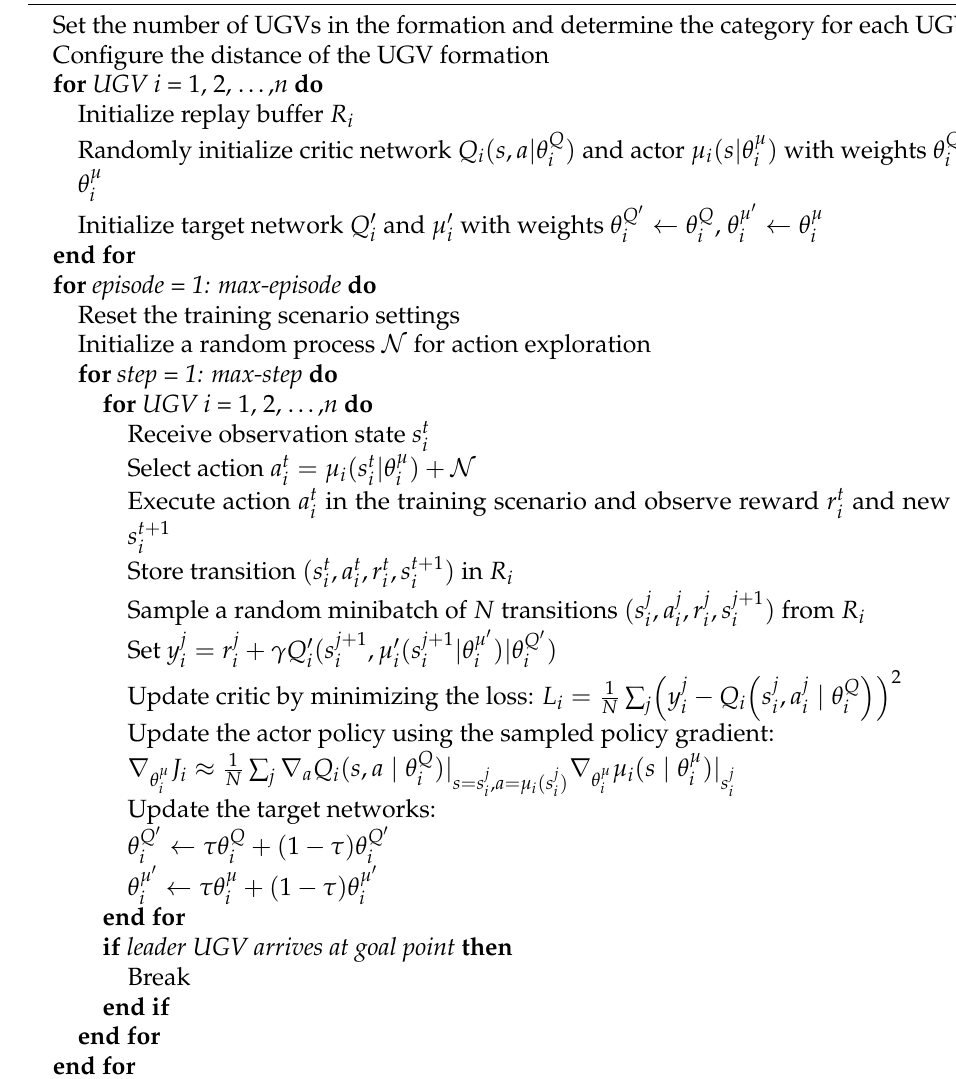
Algorithm 1 DDPG for Distributed and Scalable Cooperative Formation.